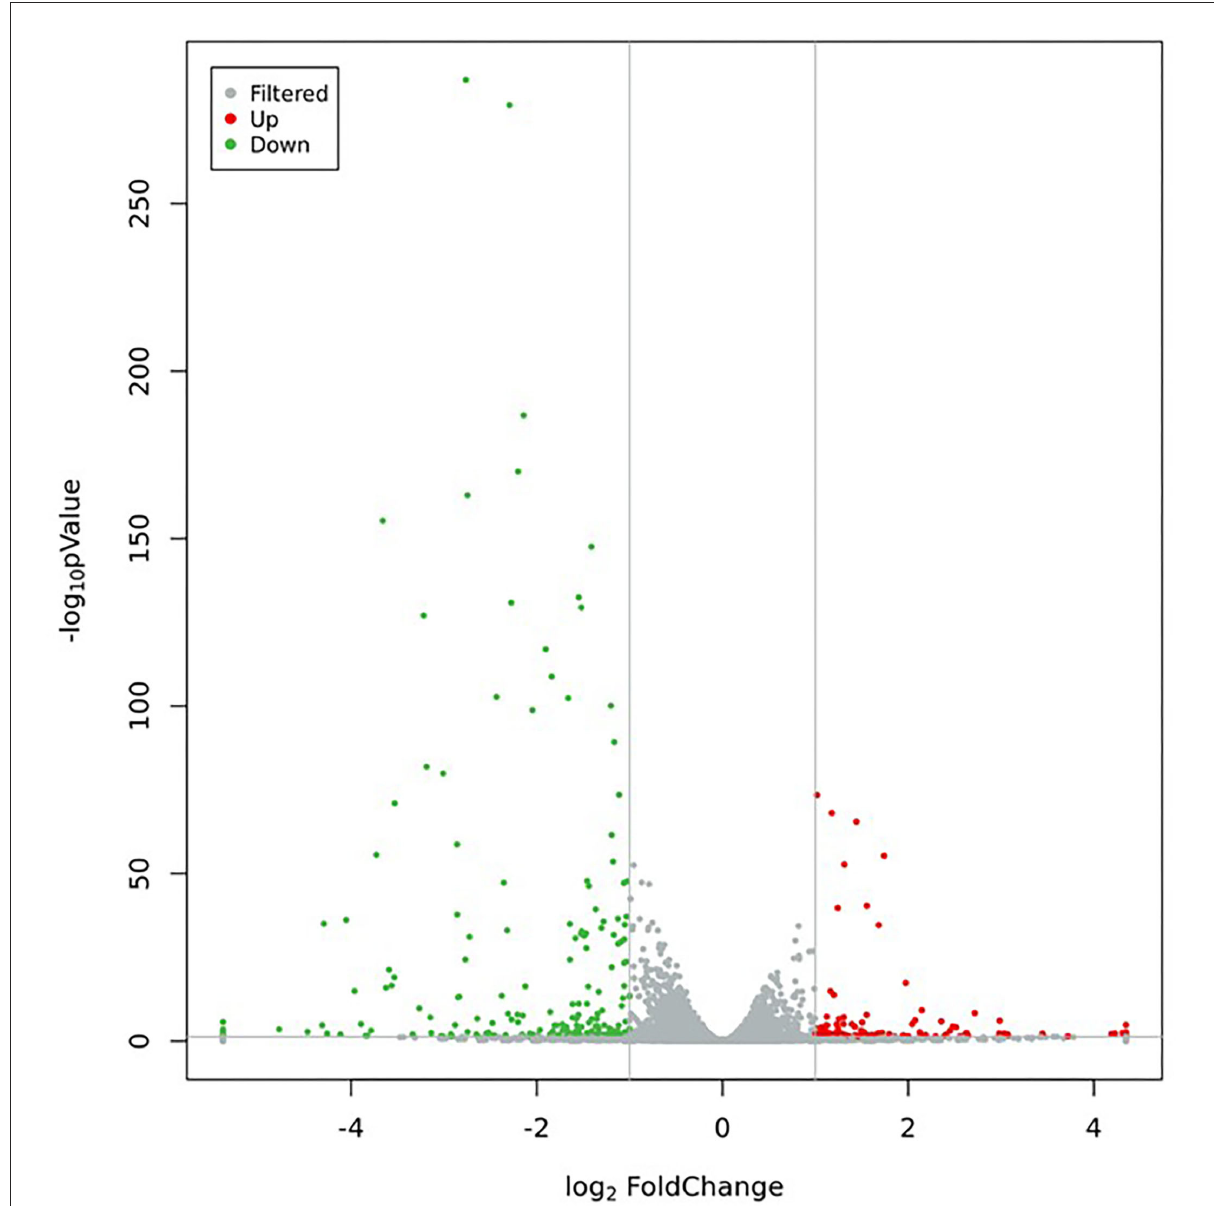
FIGURE7 Volcano plot of DEGs (Green dots represent downregulated genes, red dots represent upregulated genes, and gray dots represent no significant difference in genes).